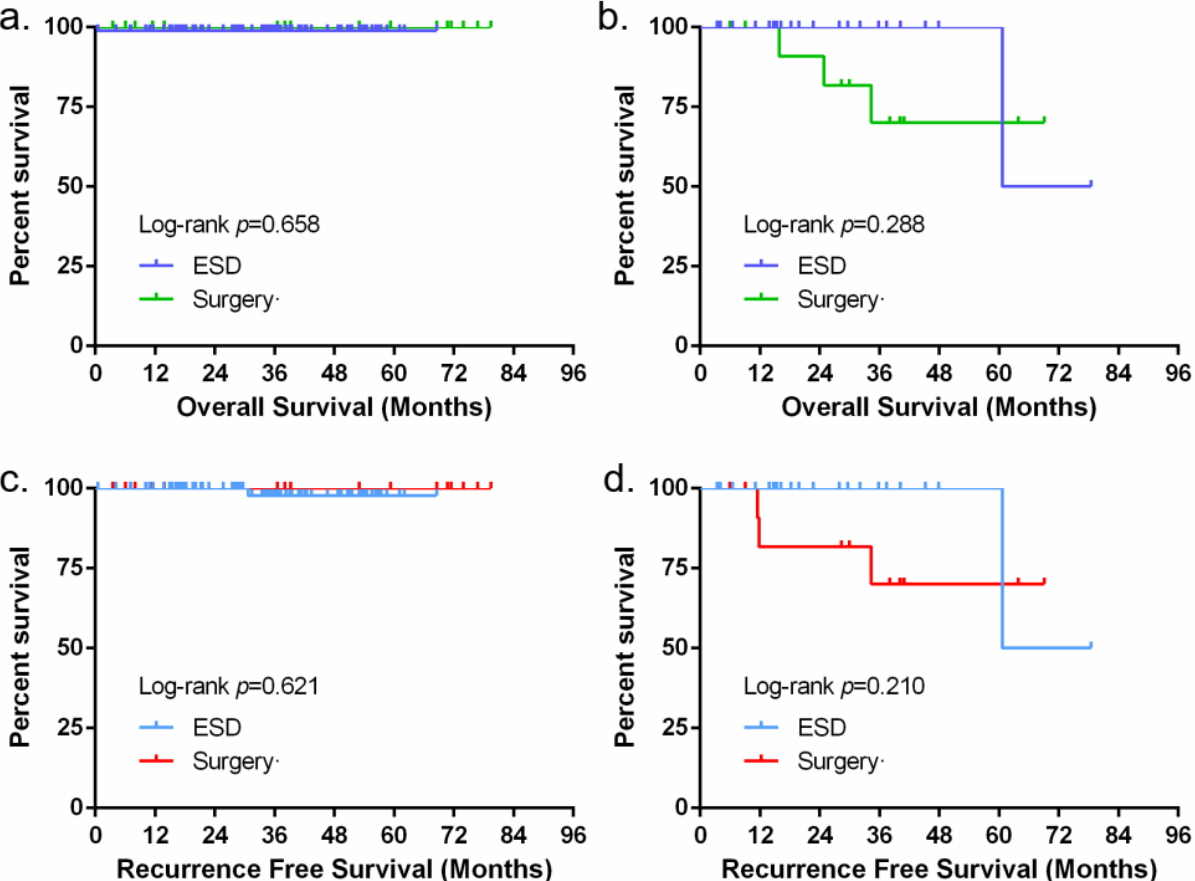
Figure 2. ( a ) Kaplan–Meier curve of overall survival for depth of invasion (<SM1); ( b ) Kaplan-Meier curve of overall survival for depth of invasion ( ≥ SM1); ( c ) Kaplan–Meier curve for recurrence-free survival for depth of invasion (<SM1); ( d ) Kaplan-Meier curve for recurrence-free survival for depth of invasion (≥SM1).